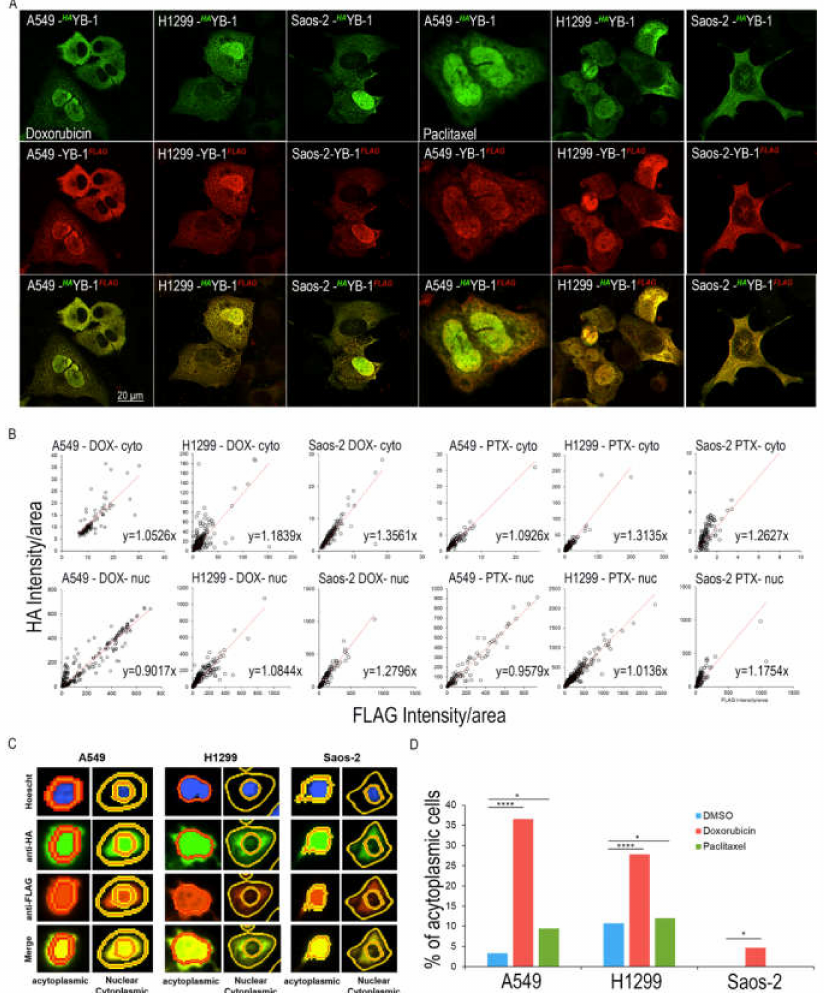
Figure 2. Full length YB-1 is present in both compartments following DNA damage. ( A ) shows the nuclear and cytoplasmic location of HA YB-1 FLAG in A549, H1299 and Saos-2 cells treated with DOX or PTX. Top row shows anti-HA which detects the N-terminus of tagged HA YB-1 FLAG , middle row shows anti-FLAG which detects the C-terminus of tagged HA YB-1 FLAG and the bottom row shows the merged image. The nucleus is stained with Hoechst, anti-HA (green) and anti-FLAG (red). ( B ) the fluorescence intensity / area for anti-HA and anti-FLAG using masks to di ff erentiate the nucleus and the cytoplasmic compartments for > 100 cells in all three cell lines. Each dot represents the intensity / area for anti-HA and anti-FLAG for each cell. The red dotted line represents the line of best fit. The slope of the line is indicated. ( C ) shows example of the masks with either the presence or absence of cytoplasmic staining of HA YB-1 FLAG using anti-HA and anti-FLAG in A549, H1299 and Saos-2 cells treated with DOX. ( D ) Shows the percentage of acytoplasmic cells; i.e. those that did not show cytoplasmic labelling with either anti-HA or anti-FLAG, indicating that YB-1 was not present in the cytoplasm of these cells. Chi-square test was used to determine significance, * p < 0.05, **** p <